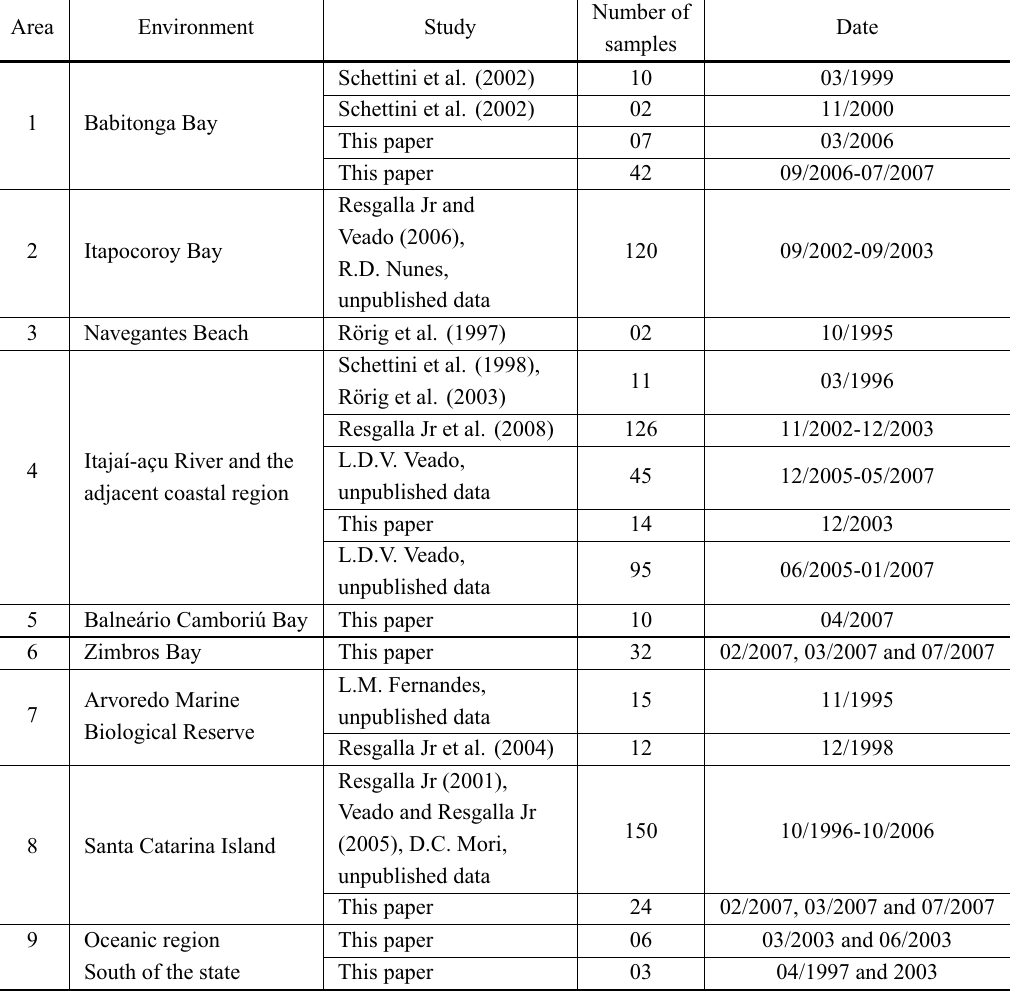
Identification of the samplings carried out on the Santa Catarina coast by environment (according to Fig. 1), type of study, number of samples and collection